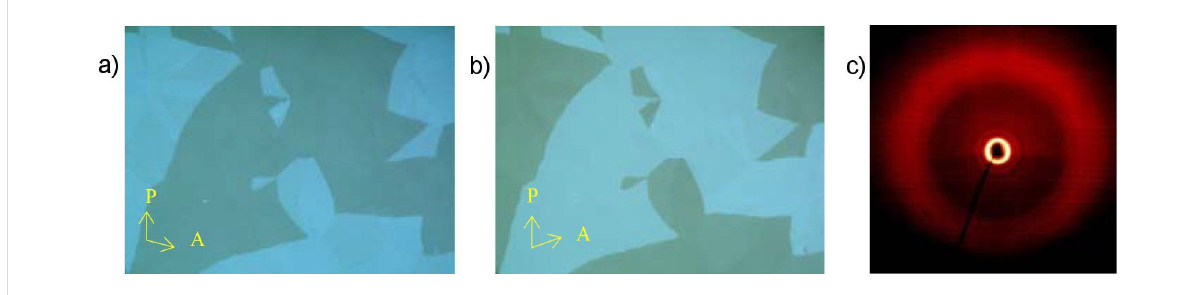
Figure 19: Compound OH 5d : Optical photomicrographs of chiral domains at 122 °C; polariser and analyser are uncrossed by about a) − 8° and b) +8° from the 90° position; c) X-ray pattern of a powderlike sample at 110 °C.